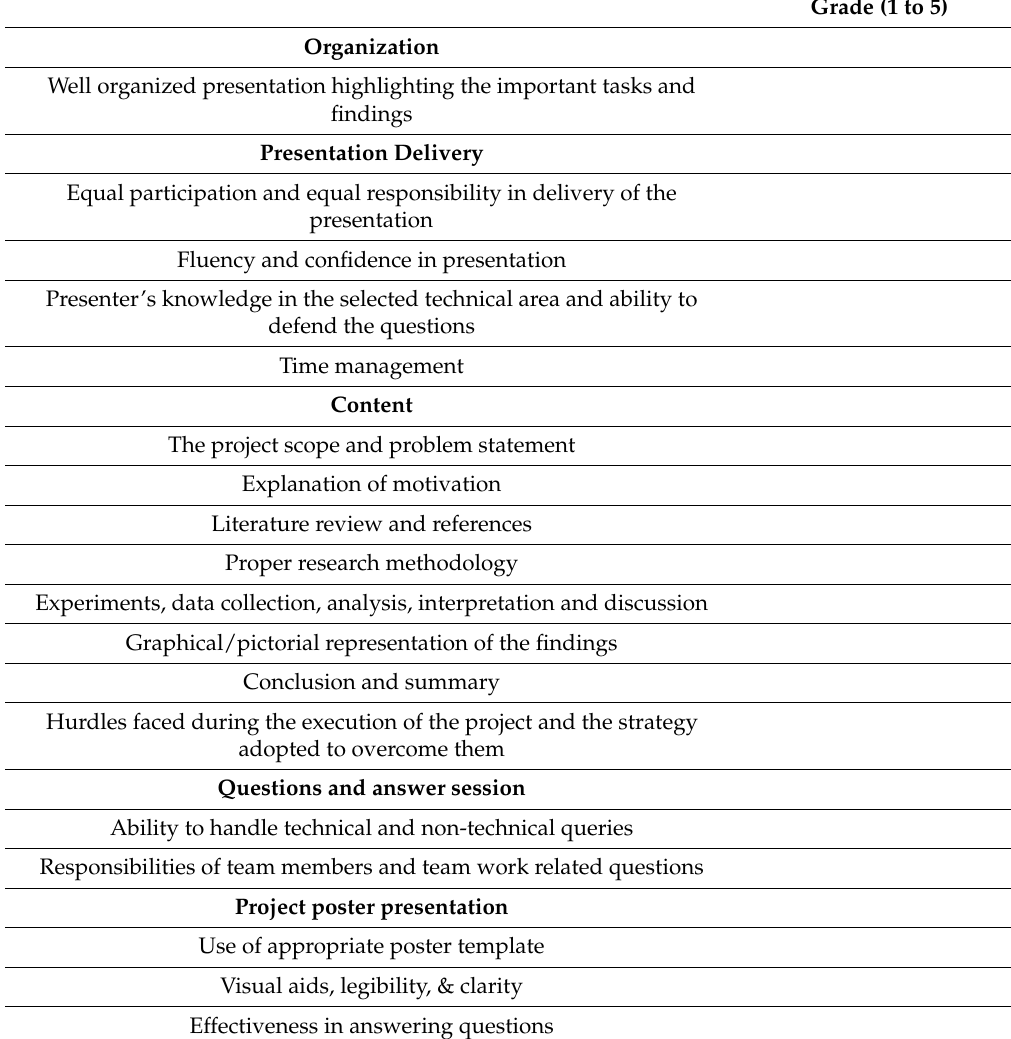
Table 10. Oral Presentation Assessment by Evaluation Panel.